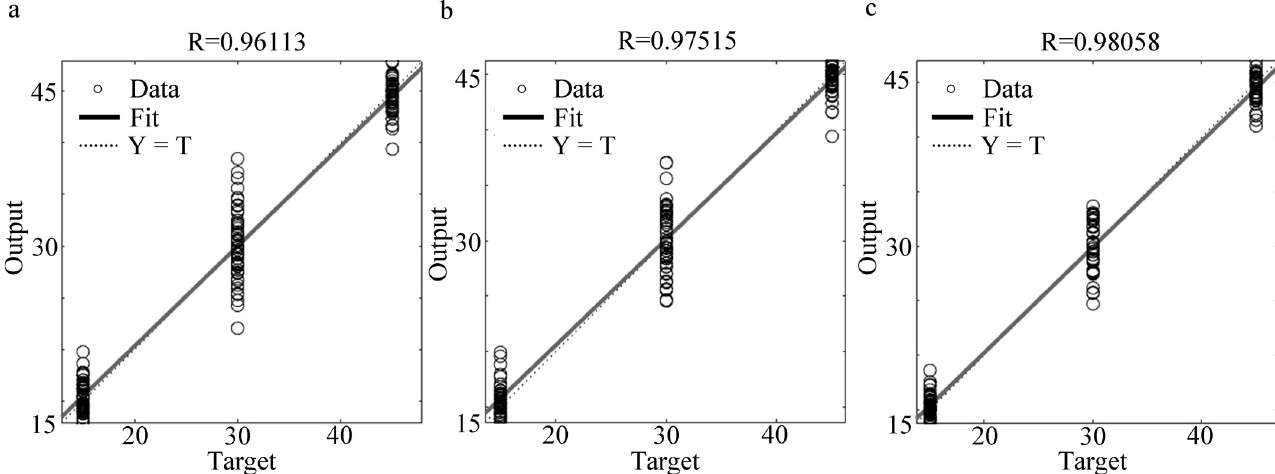
Fig 9. Comprehensive results of training electronic nose response by the backpropagation (BP) neural network. (a) Sensing system of Chamber A. (b) Sensing system of Chamber B. (c) Sensing system of Chamber C.